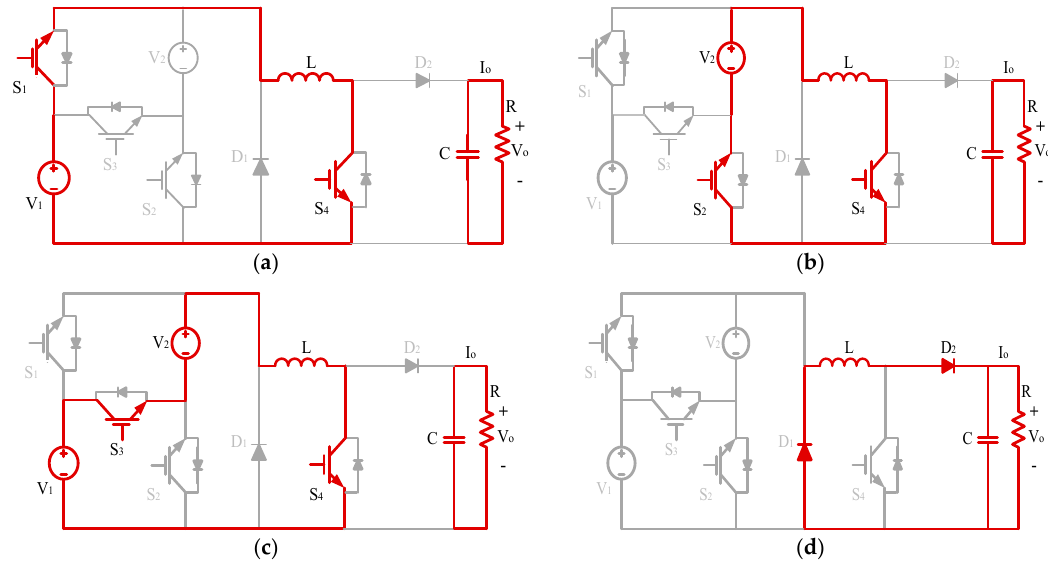
Figure 2. Different working states of the MBDC converter during buck-boost operation: ( a ) contribution from Source 1; ( b ) contribution from Source 2; ( c ) contribution of form both sources V 1 and V 2 together; and ( d ) freewheeling period.